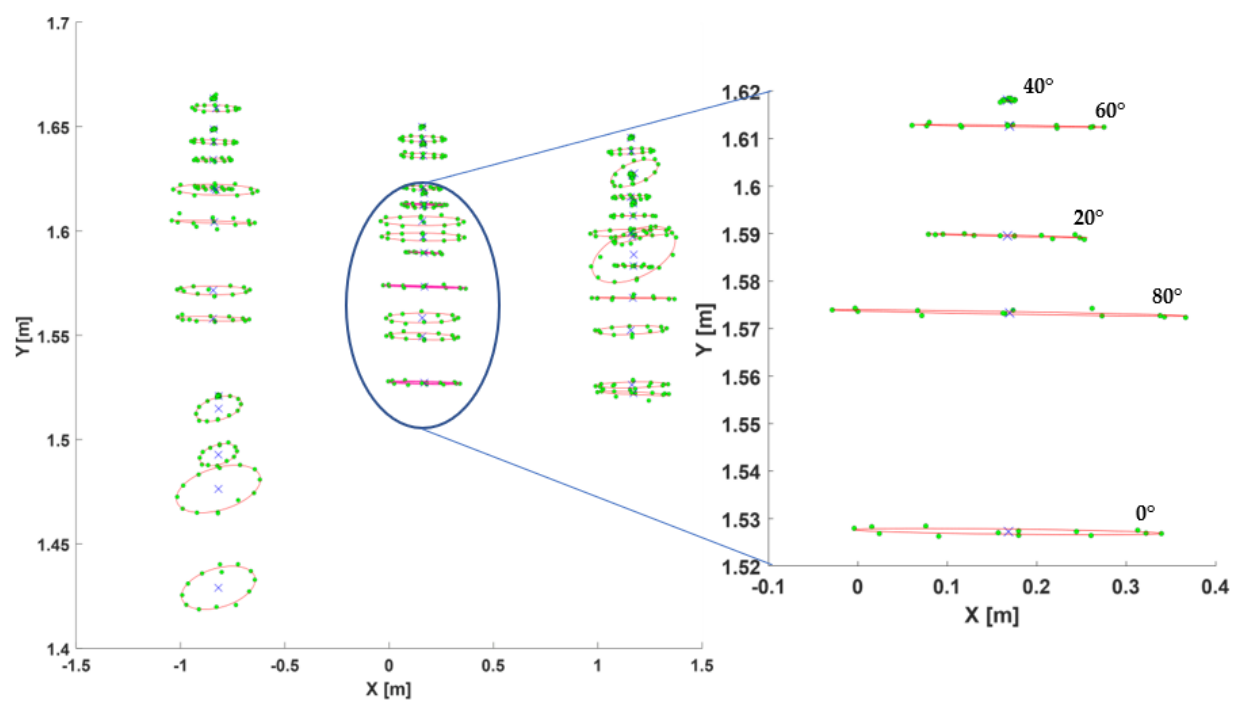
Figure 6. Tracker positions during measurements (side view). The dots indicate the tracker’s position, the red lines represent the circles with a radius determined from the results, and the crosses indicate their centres.